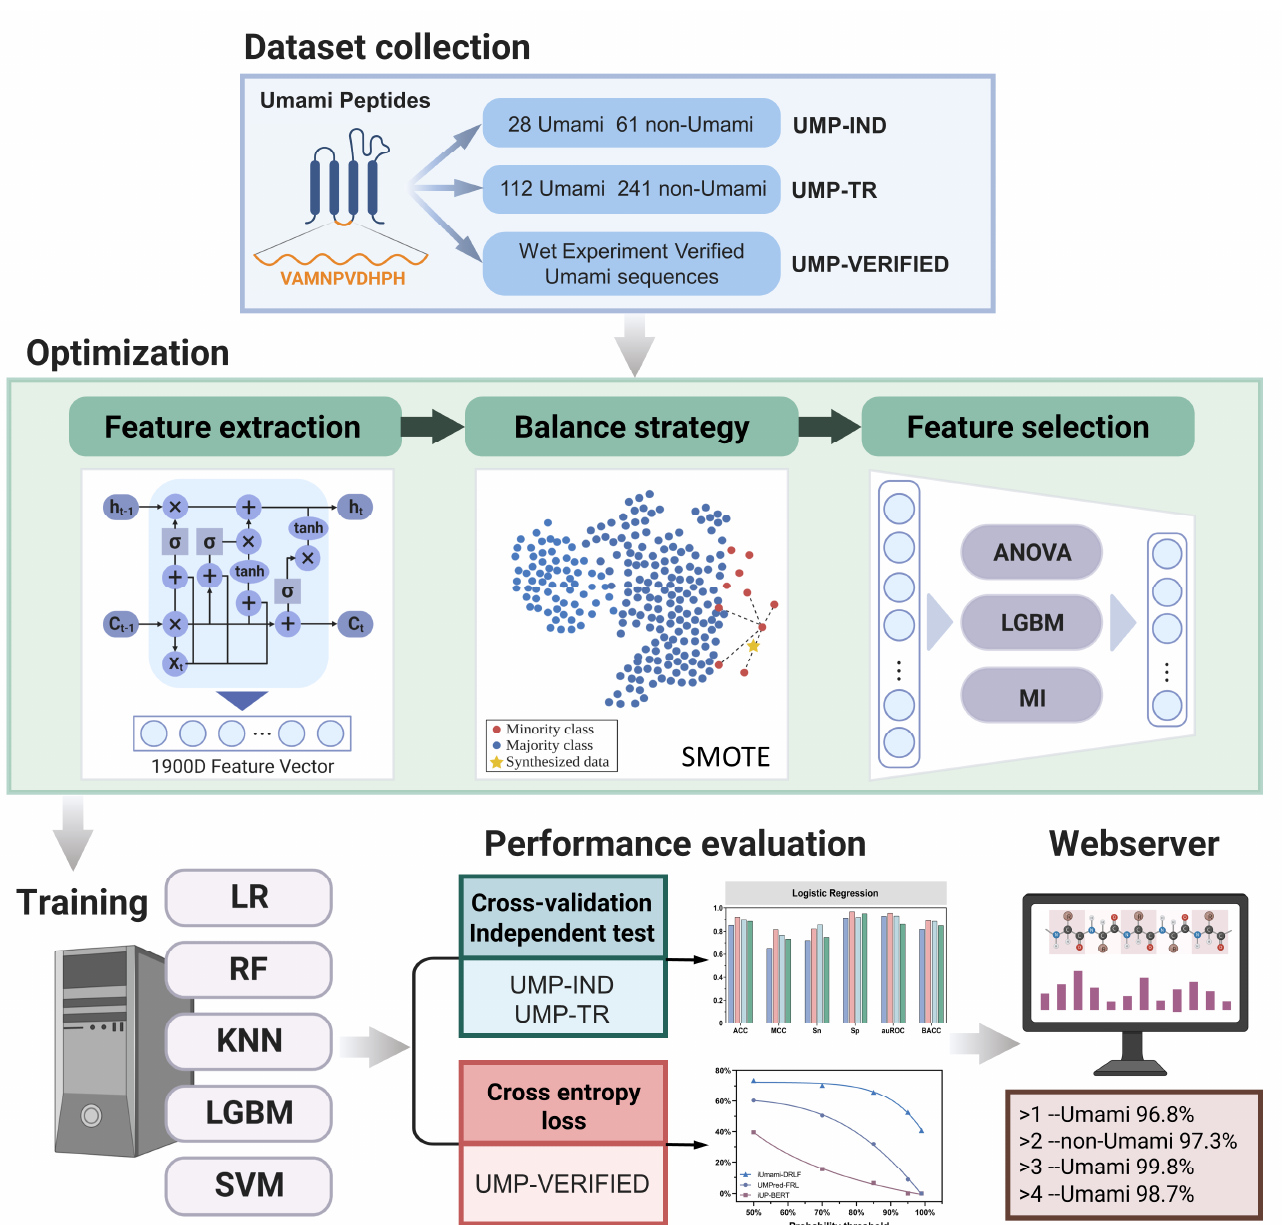
Figure 1. Overview of model development. The pre-trained UniRep sequence embedding model was used to embed the peptide sequences into eigenvectors. The peptide sequences were converted into 1900-dimensional (D) UniRep eigenvectors. The synthetic minority over-sampling technique (SMOTE) was used for balancing the imbalanced data. These features were used as inputs to the k- nearest neighbors (KNN), logistic regression (LR), support vector machine (SVM), random forest (RF), and light gradient boosting machine (LGBM) predictor algorithms. Feature extraction was performed for model optimization using analysis of variance (ANOVA), LGBM, and mutual information (MI). The selected feature sets were subjected to another round of analysis using the three feature extraction algorithms and various hyperparameters. The final optimized model was developed by comparison of model performance in 10-fold cross-validation and independent tests. Based on the 91 wet-test validated umami peptide sequences reported in the latest research (UMP-VERIFIED), we evaluated iUmami-DRLF in comparison to state-of-the-art methods.